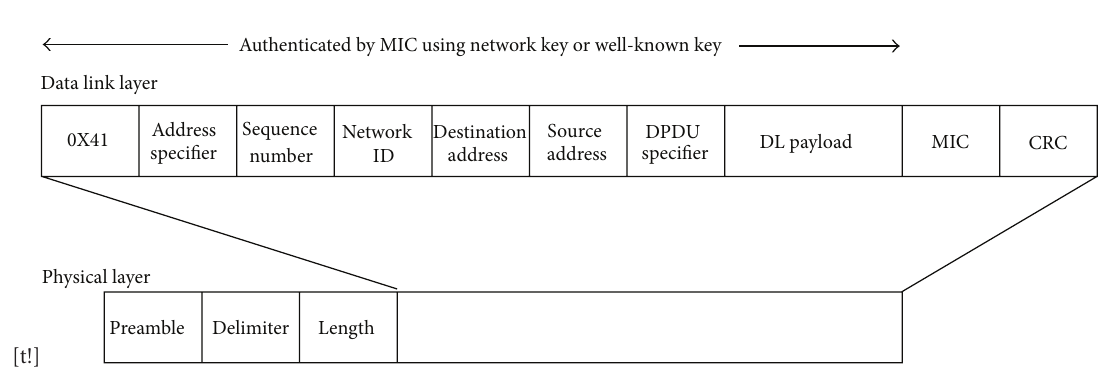
Figure 5: ISA100.11a DPDU.